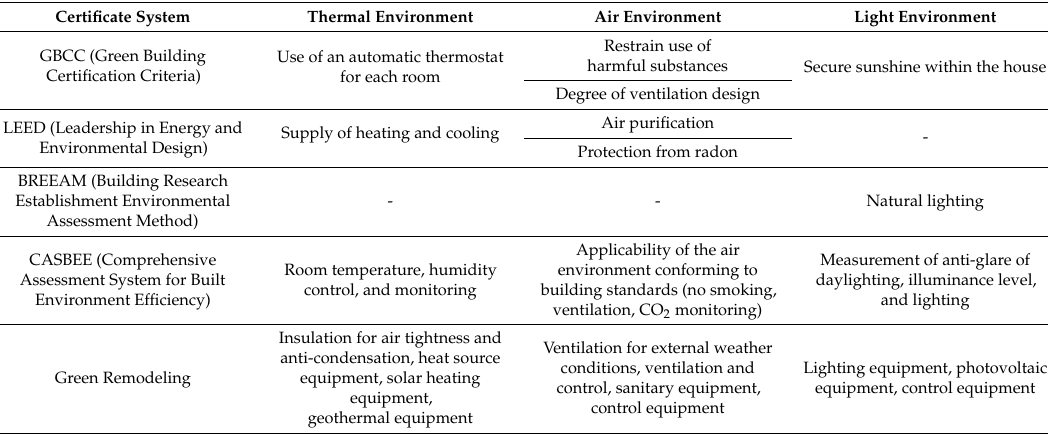
Table 1. Evaluation Items of Eco-Friendly Architecture and Green